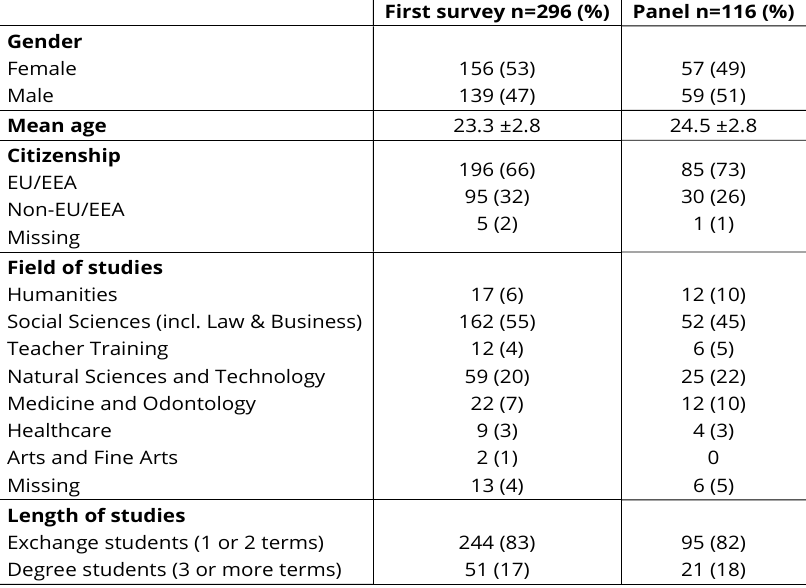
Table 1. A description of the participants in the first survey and the panel (i.e. the students who answered both